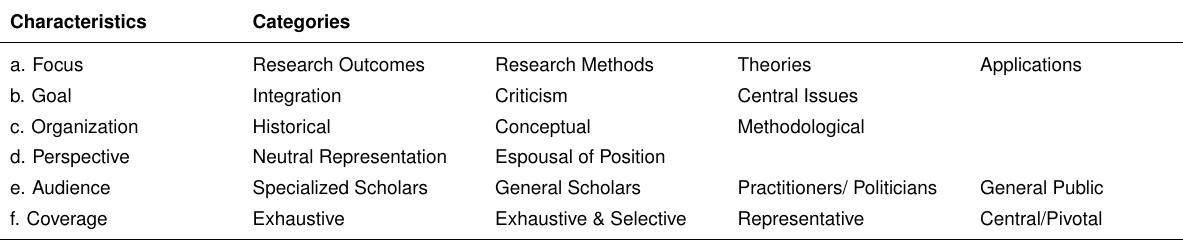
Table 2. Scope Definition Taxonomy. Adapted from